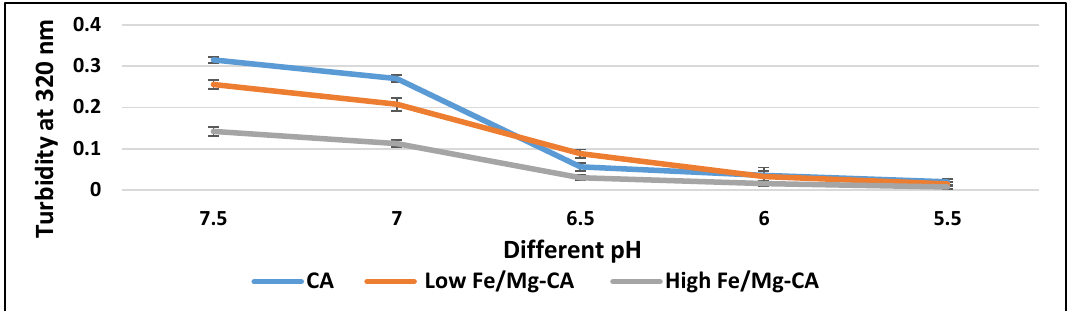
Figure 10. Dissolution profiles of CA (20 mM Ca 2+ ), low Fe/Mg-CA (20 mM Ca 2+ , 5 µM Fe 3+ and 20 mM Mg 2+ ), and high Fe/Mg-CA (20 mM Ca 2+ , 25 µM Fe 3+ and 60 mM Mg 2+ ) NPs with decreasing pH. The particles were prepared in 200 µ L freshly prepared DMEM media, prior to incubation at 37 ◦ C for 30 min. Then 800 µ L of DMEM media of di ff erent pHs (7.5, 7, 6.5, 6 and 5.5) was supplemented to each